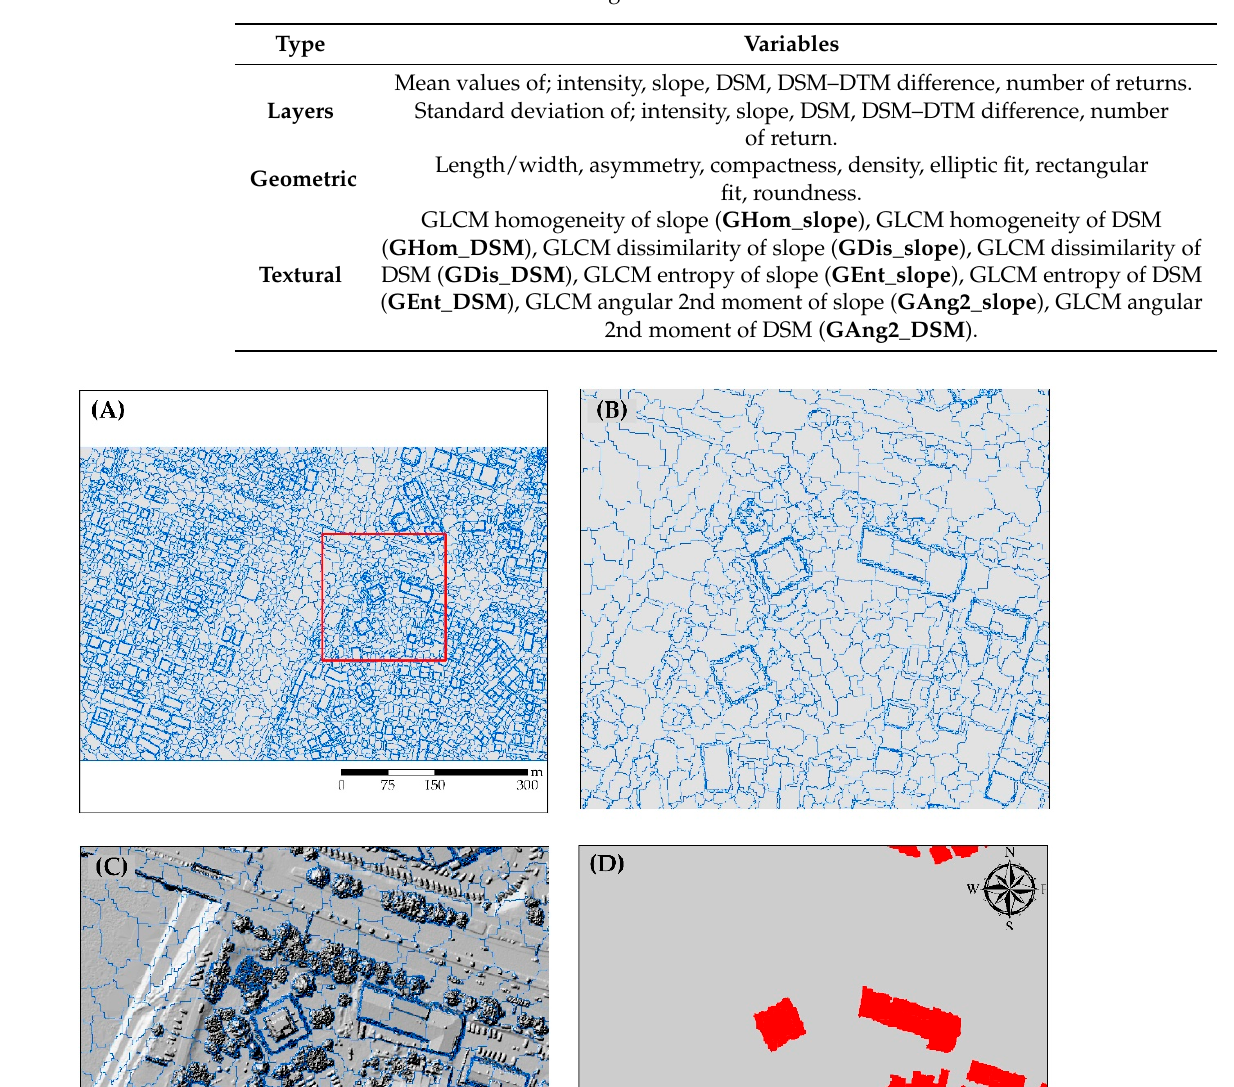
Table 1. Selected variables for building extraction.